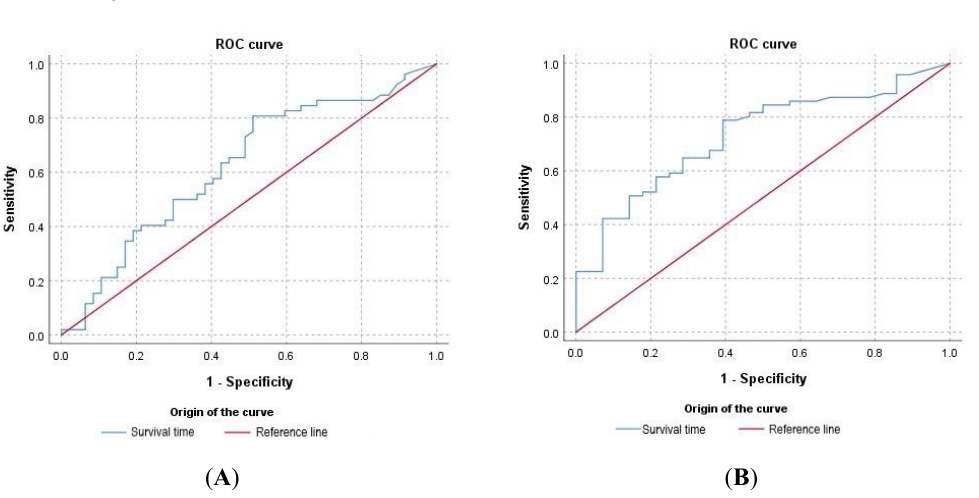
Figure 4. Influence of blood urea levels and IRIS stage on the survival time of patients with CanL. Receiver Operating Characteristic (ROC) curves were used to assess the survival time predictive value of a normal urea value ( A ) or IRIS value of 1 (normal) ( B ) at the time of diagnosis in survival time. Both events (death) and censored data were